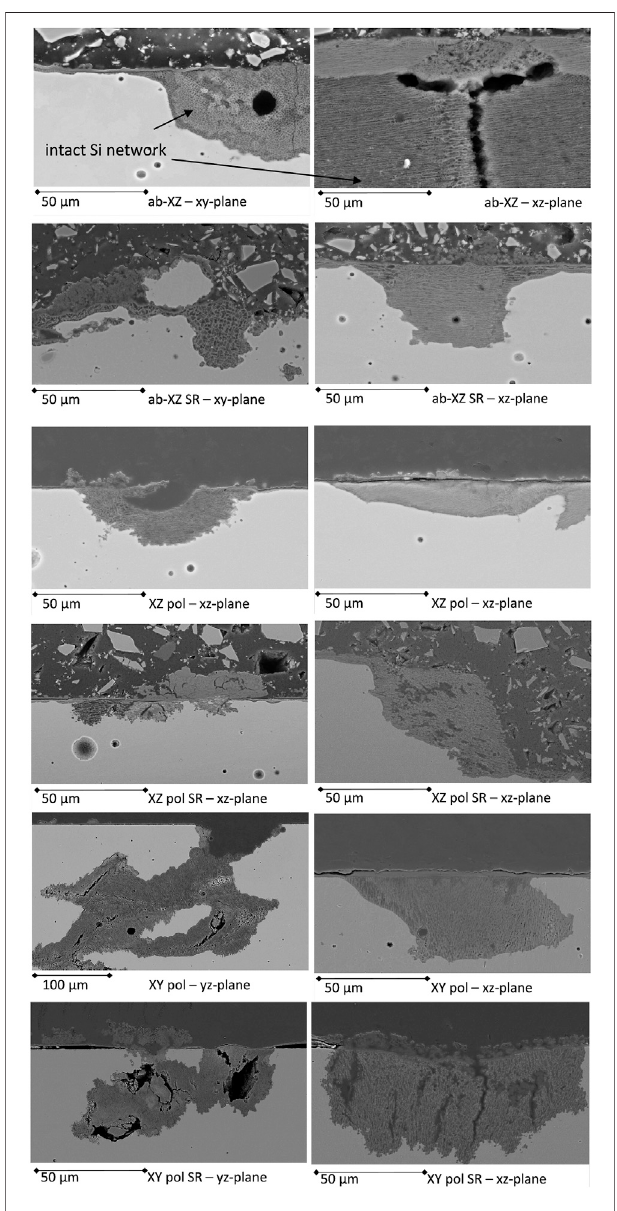
FIGURE8| Cross-sectionsofthecorrosion-testedAMsurfaceswiththe most prominent corrosion events observed in different printing directions.